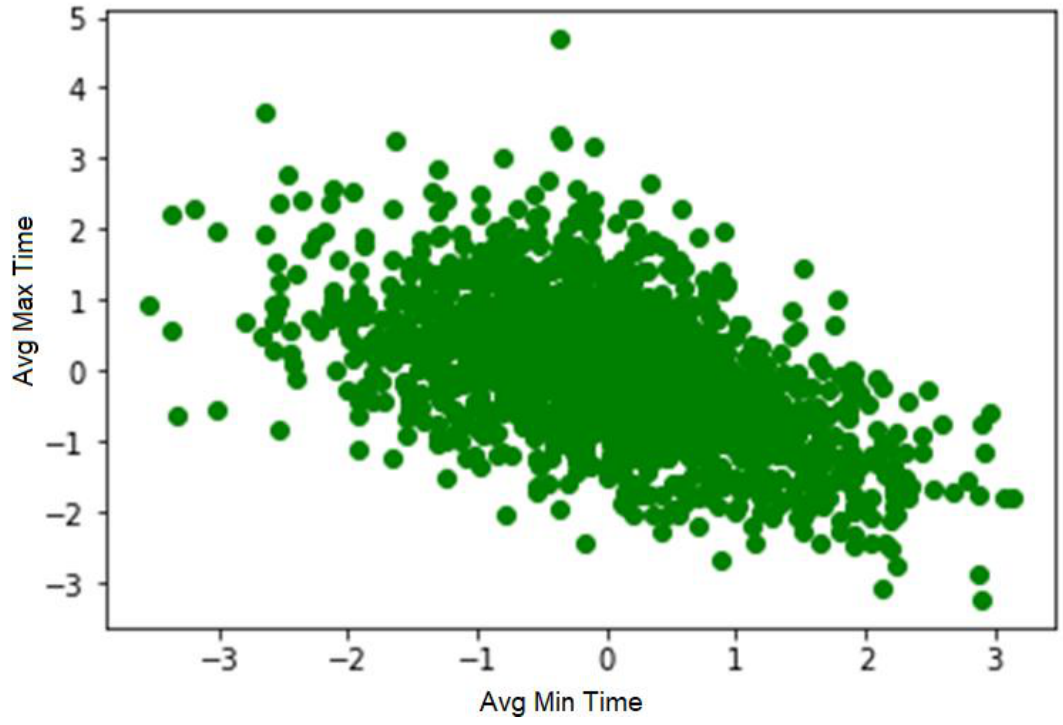
Figure 2. Sample scatter plot visualization in Jupyter software.